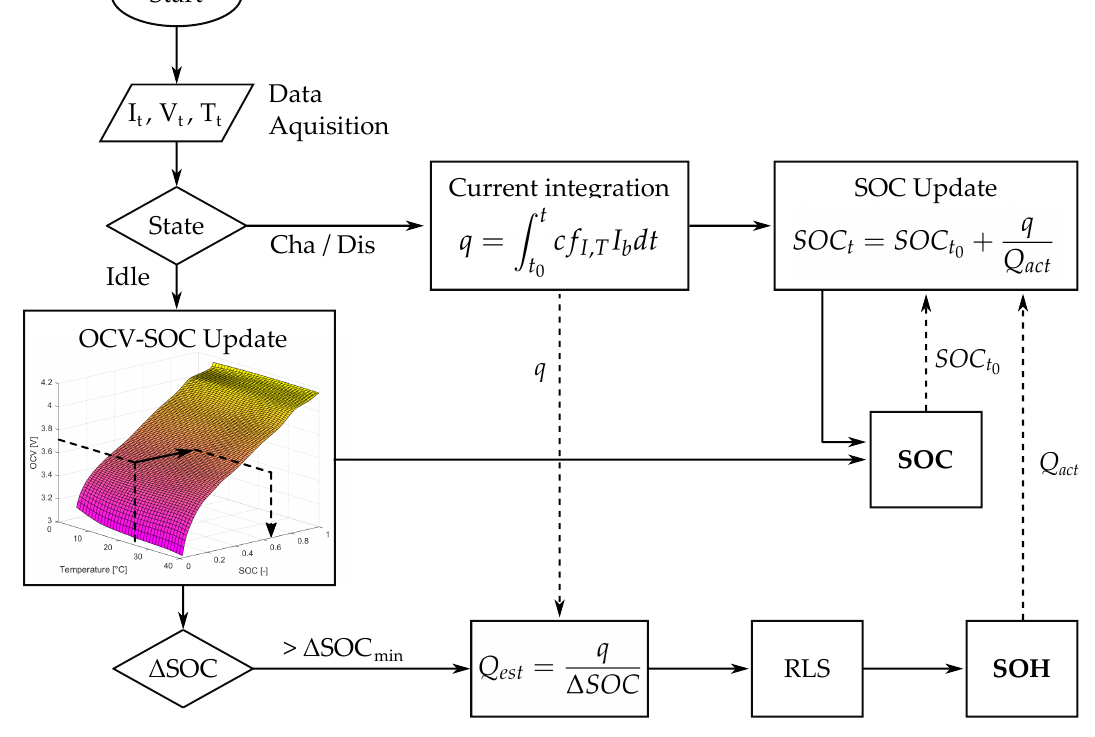
Figure 6. Flowchart of the proposed estimation